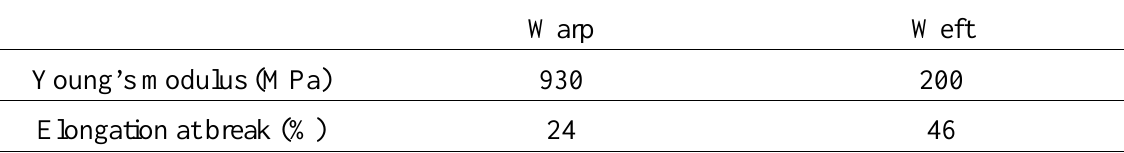
Table 2. Fabric’s tensile